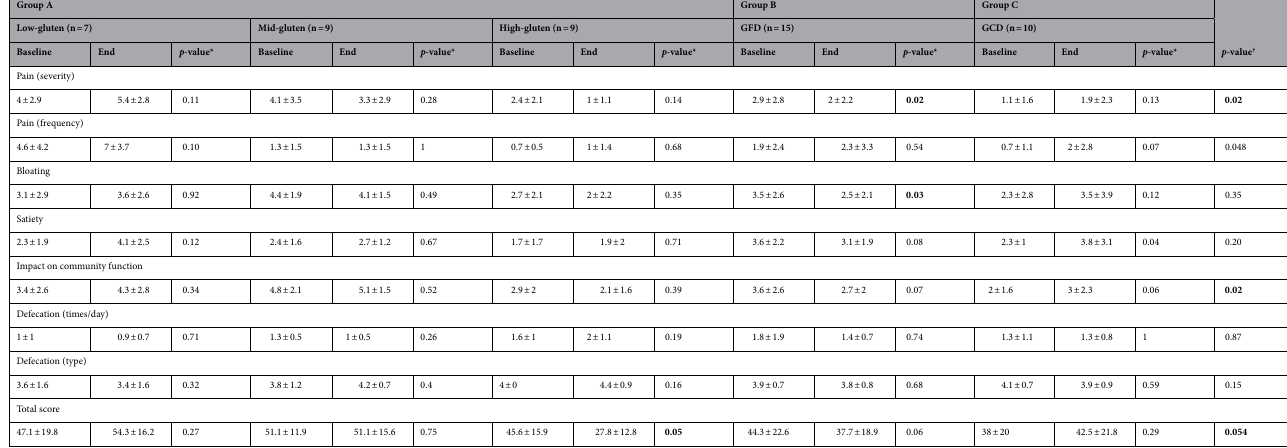
Table 3. Comparison of VAS scores within groups and between groups at the end of the study [Mann– Whitney U test was used for testing each two groups. There were no significant differences between each two groups, except between low gluten and high gluten diet for abdominal pain (p = 0.002), and mid gluten and high gluten diet for impact on community function (p = 0.003)]. * p -value for comparison within each group using the Wilcoxon-signed rank test. † p -value for between-groups comparison using the Kruskal–Wallis test.